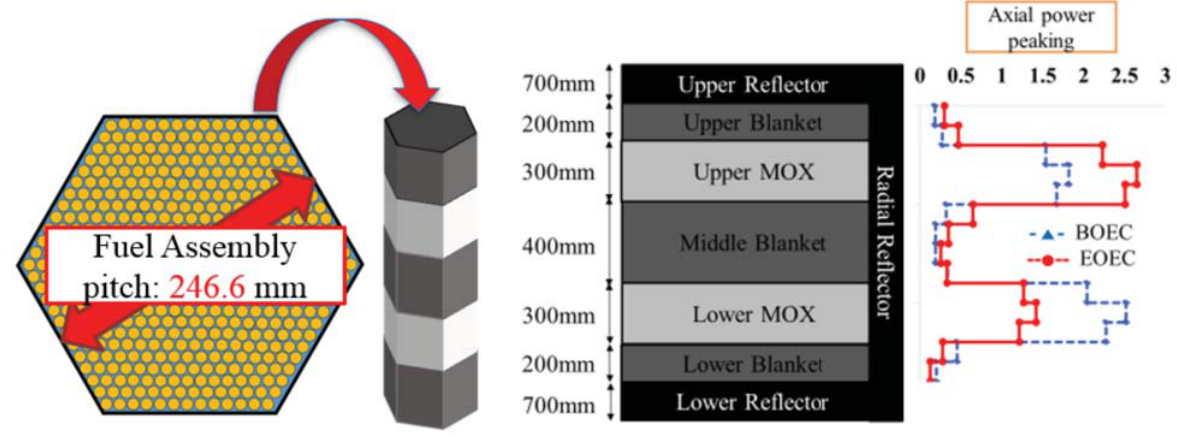
Figure 2: Fuel assembly design and axial core configuration